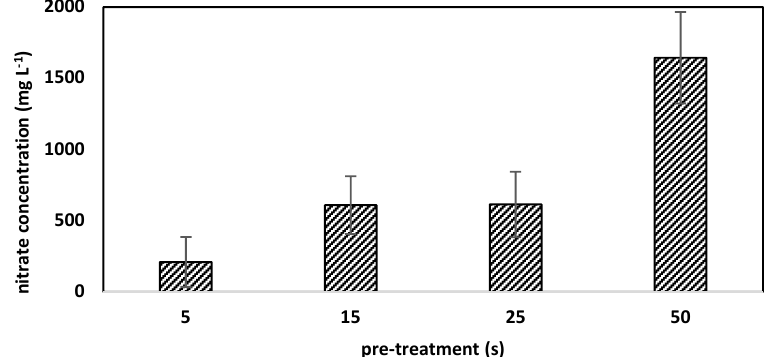
Figure 5. Nitrate concentrations (mg L − 1 ) of PTW (plasma-treated water) with pre-treatment time (plasma on) from five up to 50 seconds measured by ion chromatography. N = 10. Standard deviations are given be error bars.